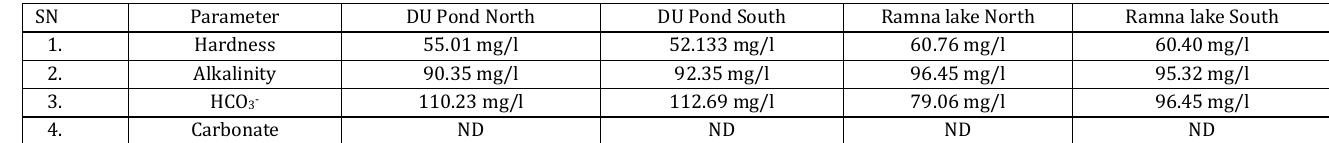
Table 2: Result of Chemical Parameters